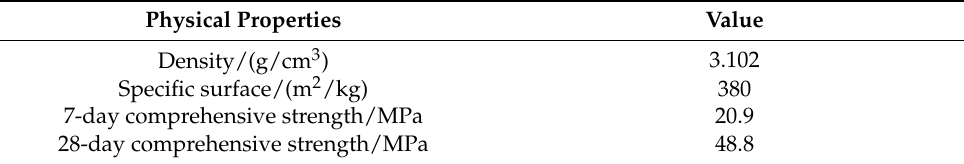
Table 2. Physical and mechanical properties of ordinary Portland cement.